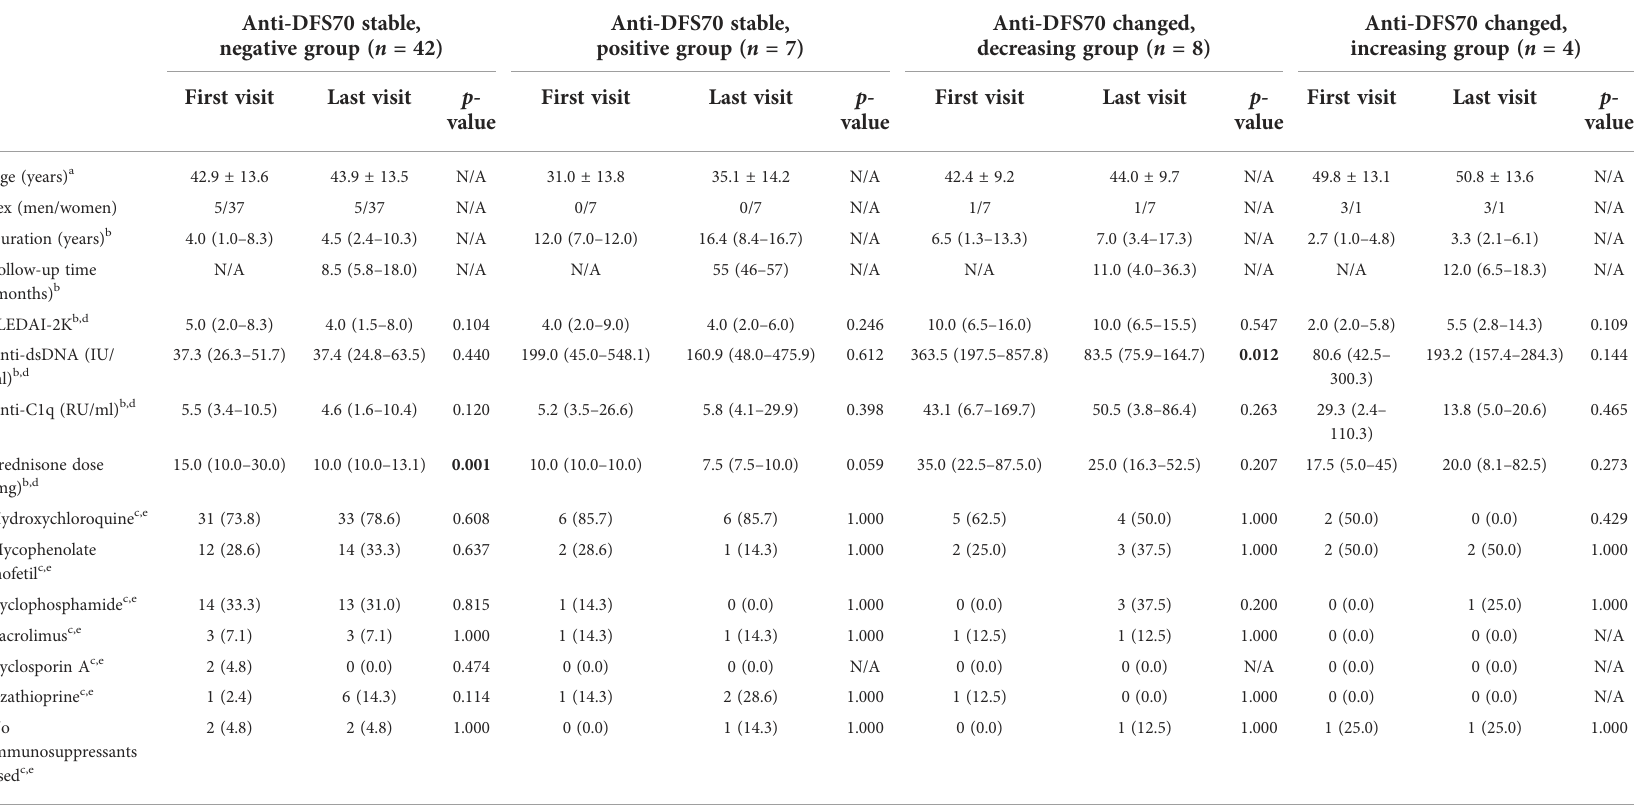
TABLE 3 Characteristics of follow-up patients with SLE as grouped by variation of anti-DFS70 antibodies at the fi rst and last